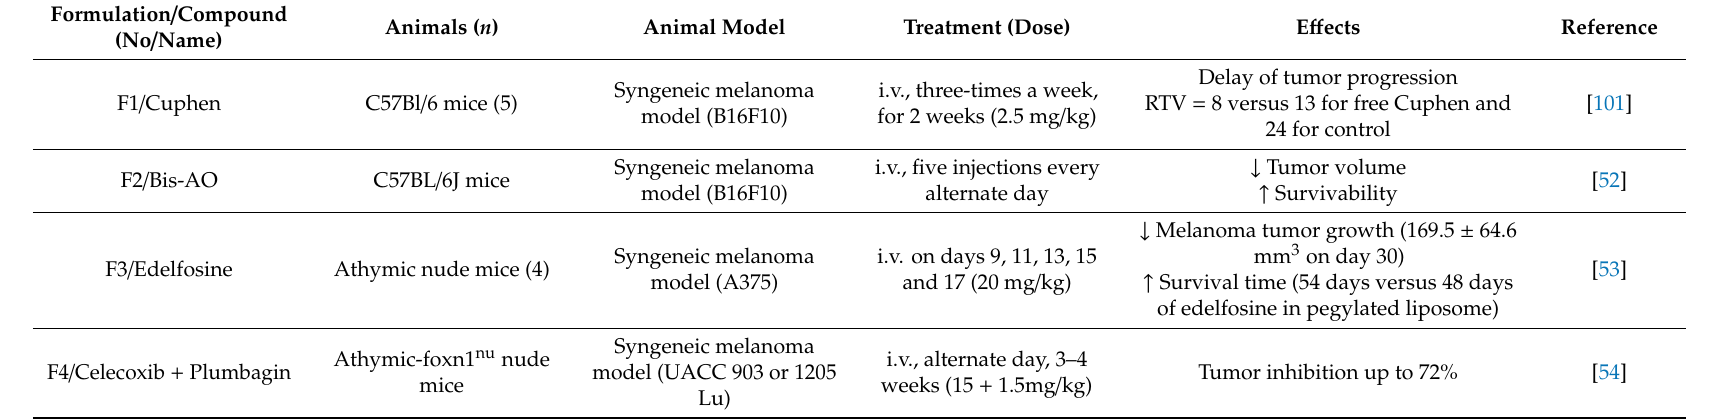
Table 5. In vivo proof of concept studies of nanoformulated compounds in melanoma murine